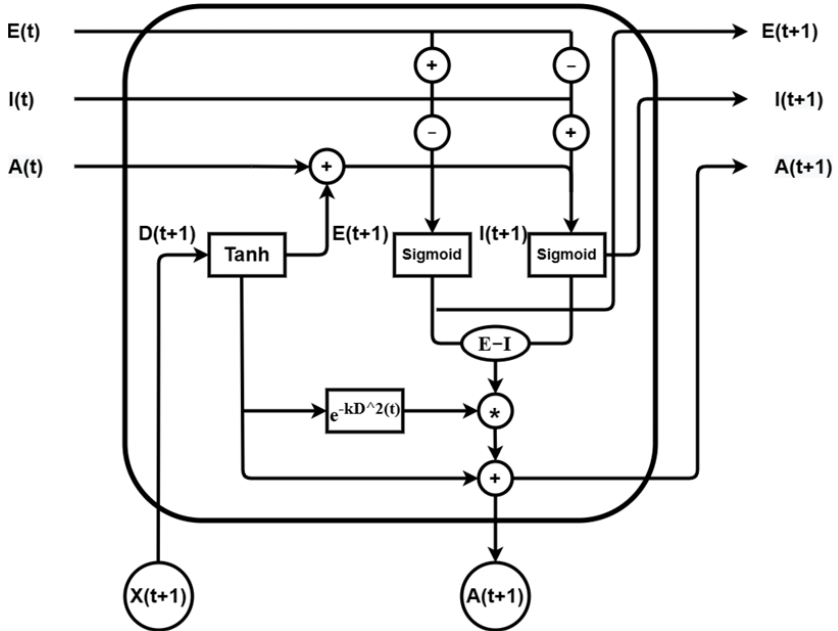
Figure 1. Diagram of EINS